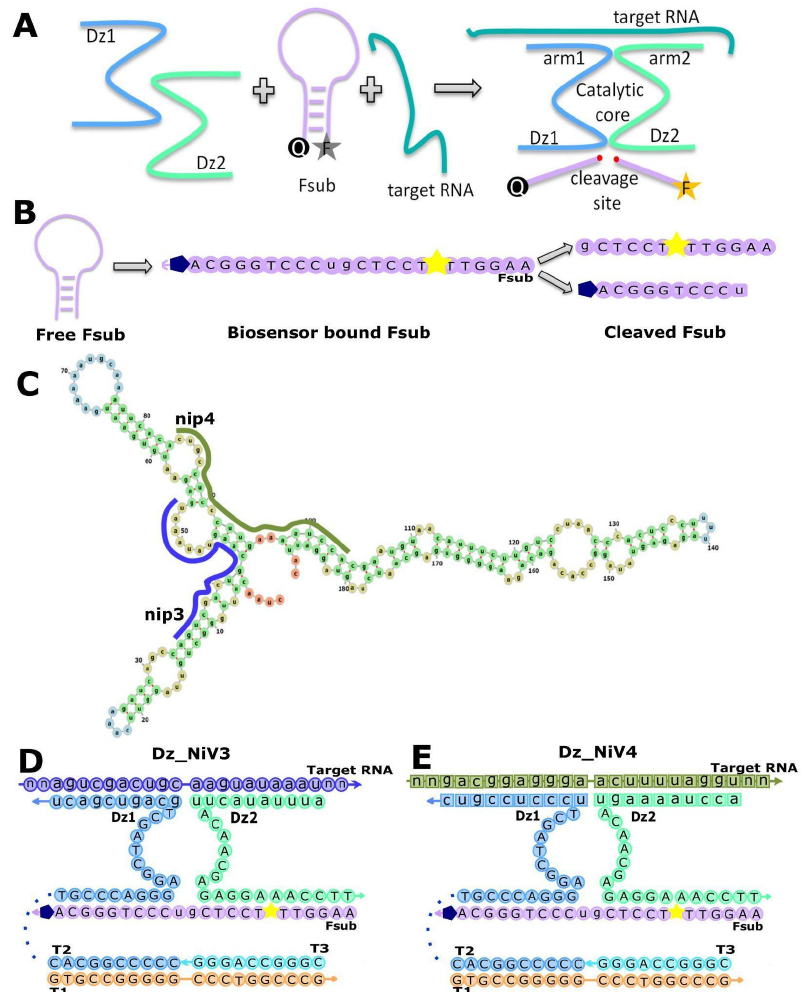
Figure 1. The principle of the deoxyribozyme biosensor design and activity. ( A ) Target RNA detection in the presence of the binary probe and fluorescent substrate (Fsub). ( B ) The Fsub structure before and after its cleavage with Dz_NiV. ( C ) Secondary structure of the G gene of Nipah virus. Purple and green lines indicate RNA regions complementary to DNAzyme arms Dz_NiV3 and Dz_NiV4, respectively. ( D ) Dz_NiV3 design consisting of T1, T3, nip_Dz1_T2_v3 and nip_Dz2_v3. ( E ) Dz_NiV4 design consisting of T1, T3, nip_Dz1_T2_v4 and nip_Dz2_v4. The arrows indicate the 5’-3’ direction of the sequence. The yellow stars indicate the FAM fluorophore, the blue pentagons the BHQ1 quencher and the dotted lines the oligos connecting the hexaethylene glycol linker (HEG).